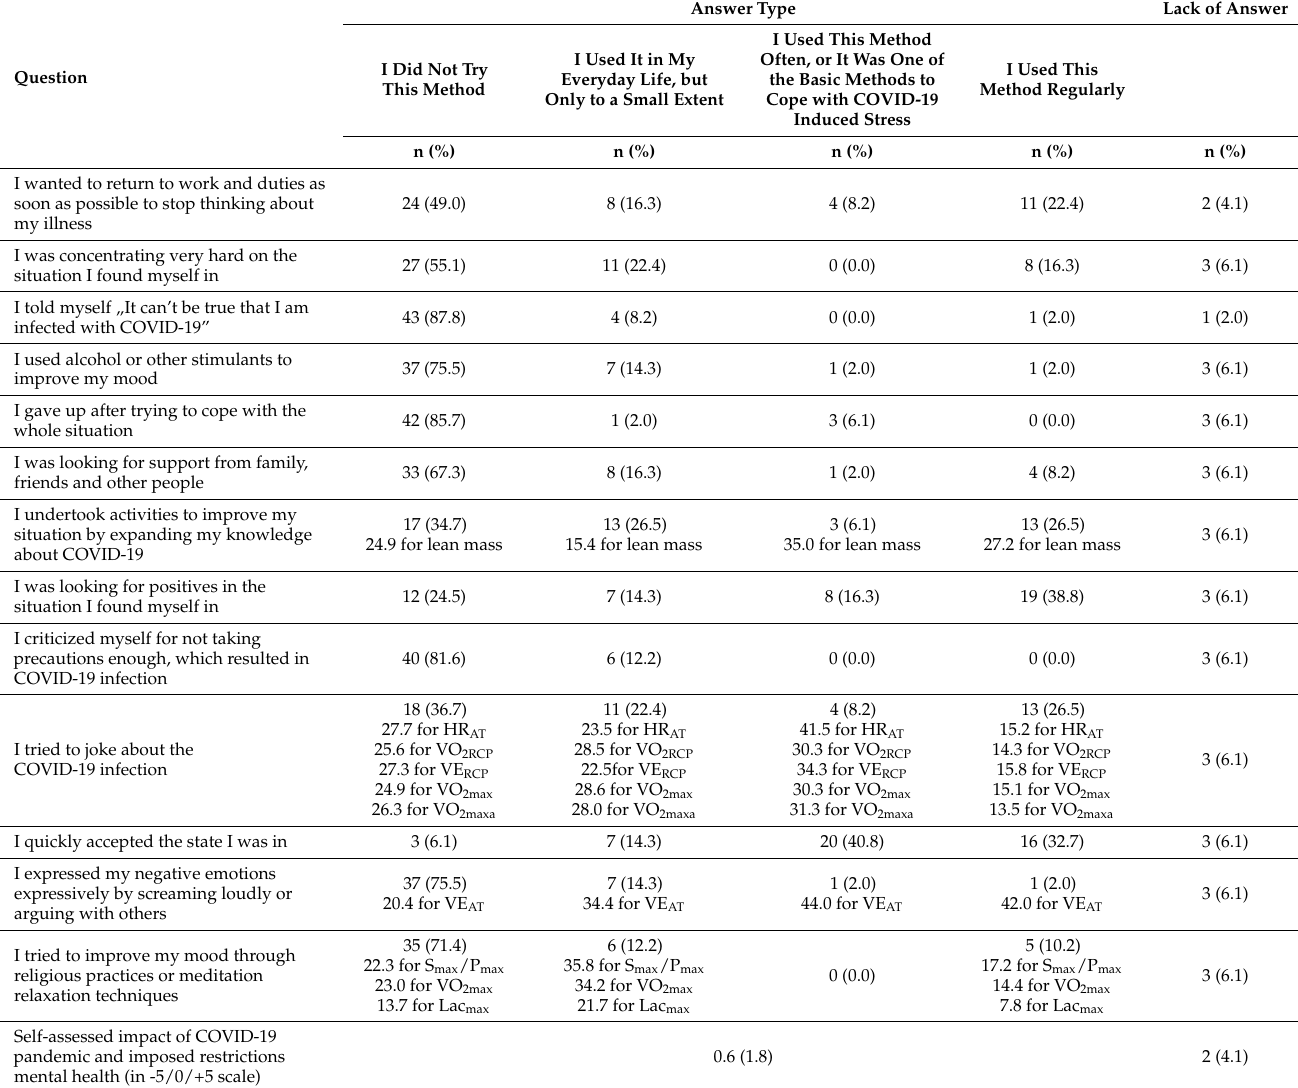
Table 3. Results of answers to questions related to mental health.